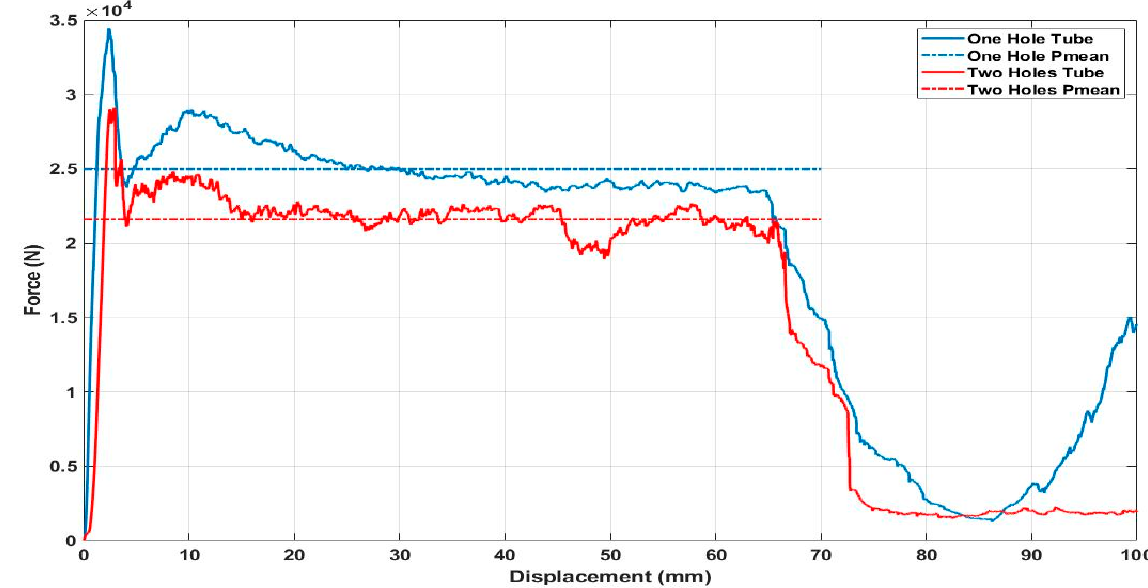
Figure 8. Force–displacement curves for the Tubes with 20 mm hole, 100 mm from chamfered top (average).